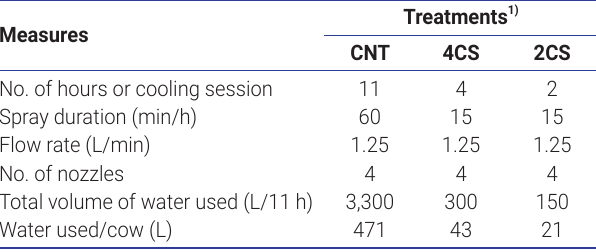
Table 1. The different measures of each treatment group with re- spect to groundwater usage